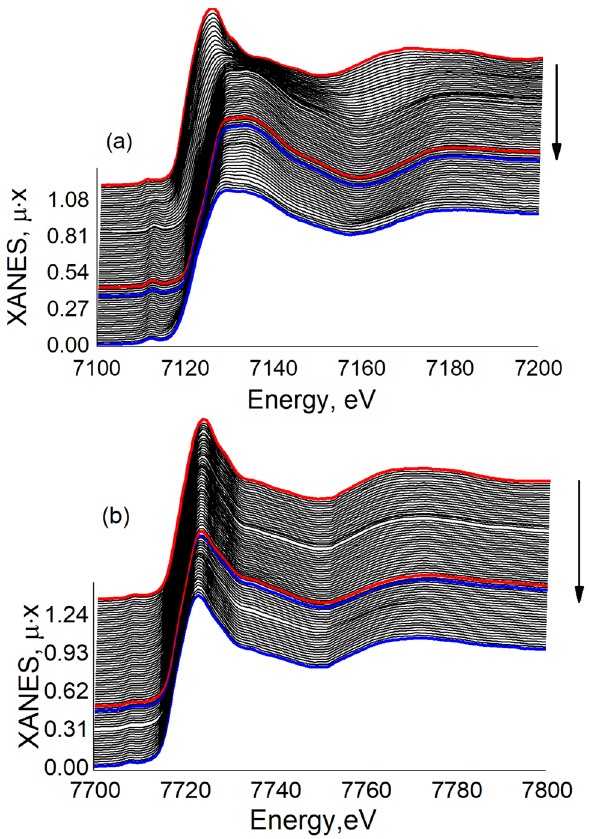
Figure 5. A series of operando XANES spectra for the Fe ( a ) and Co ( b ) K-edge in the LiCo 0.5 Fe 0.5 PO 4 cathode material obtained during the first cycle (the red line is a charging process, and the blue line represents the discharge